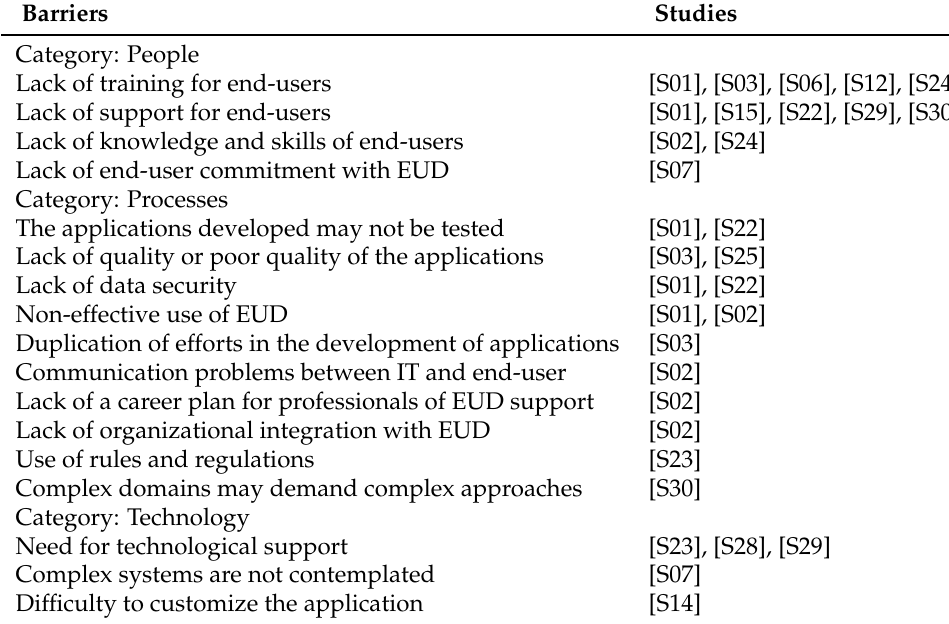
Table 7. Barriers to the adoption of